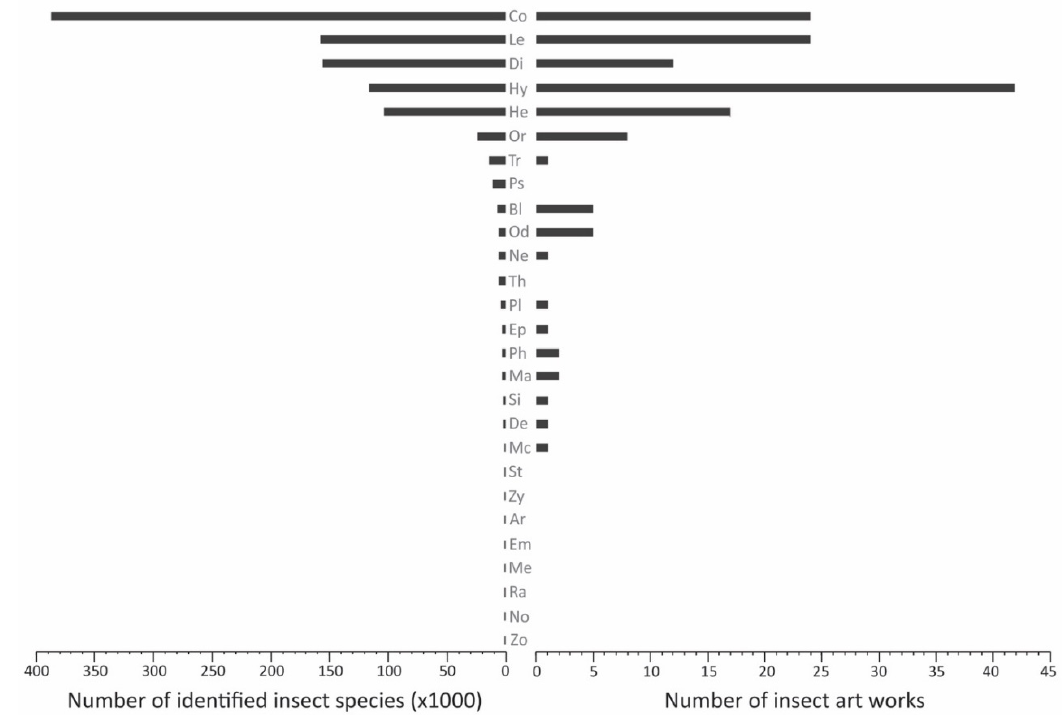
Figure 10. Numbers of surveyed artworks that address human-induced environmental disturbance, and total number of insect species known, organized by insect order. Each artwork potentially features more than one insect order, but each order is calculated here no more than one time per artist. Data here represent 68 of the surveyed artists (whose art has a dis- crete set of known, identifiable insect orders; n = 148 order associations). Ordinal abbrevia- tions: Ar = Archaeognatha, Bl = Blattodea (including Isoptera), Co = Coleoptera, De = Dermaptera, Di = Diptera, Em = Embioptera, Ep = Ephemeroptera, He = Hemiptera, Hy = Hymenoptera, Le = Lepidoptera, Ma = Mantodea, Mc = Mecoptera, Me = Megaloptera, Ne = Neuroptera, No = Notoptera, Od = Odonata, Or = Orthoptera, Ph = Phasmida, Pl = Plecoptera, Ps = Psocodea, Ra = Raphidioptera, Si = Siphonaptera, St = Strepsiptera, Th = Thysanoptera, Tr = Trichoptera, Zo = Zoraptera, Zy = Zygentoma. Species numbers and order names adopted from Stork [70], though we collapsed Phthiraptera and Psocoptera into Psocodea, and Mantophasmatodea and Grylloblat- todea into